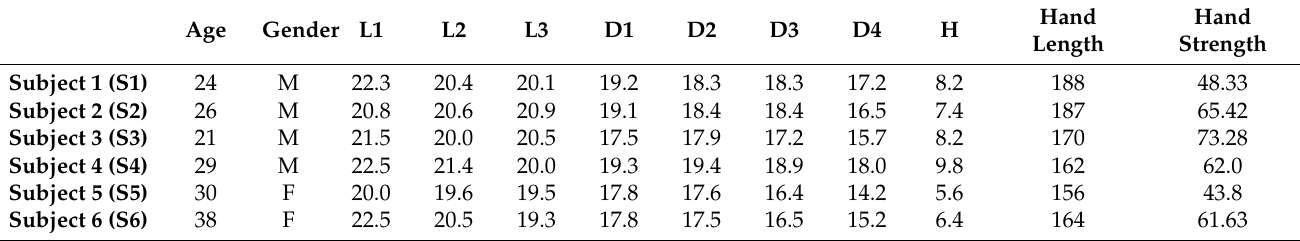
Figure 2. The ab/d DOFs restrictor. ( a ) Parameter definition, ( b ) three types of restrictors, ( c ) a human hand wearing the restrictor. Table 1. Parameters of the hands of the